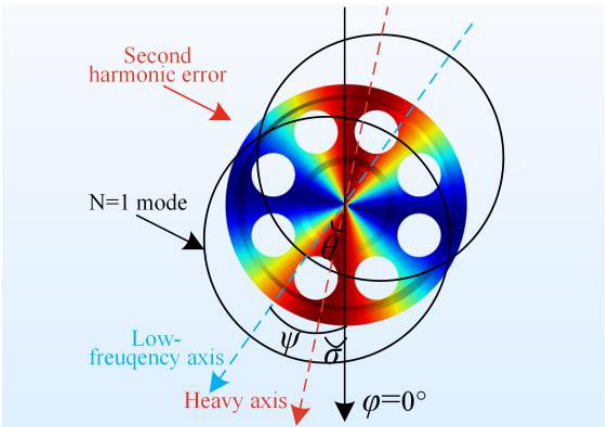
Figure 10. The low-frequency axis of the n = 1 mode and the heavy axis of the second harmonic